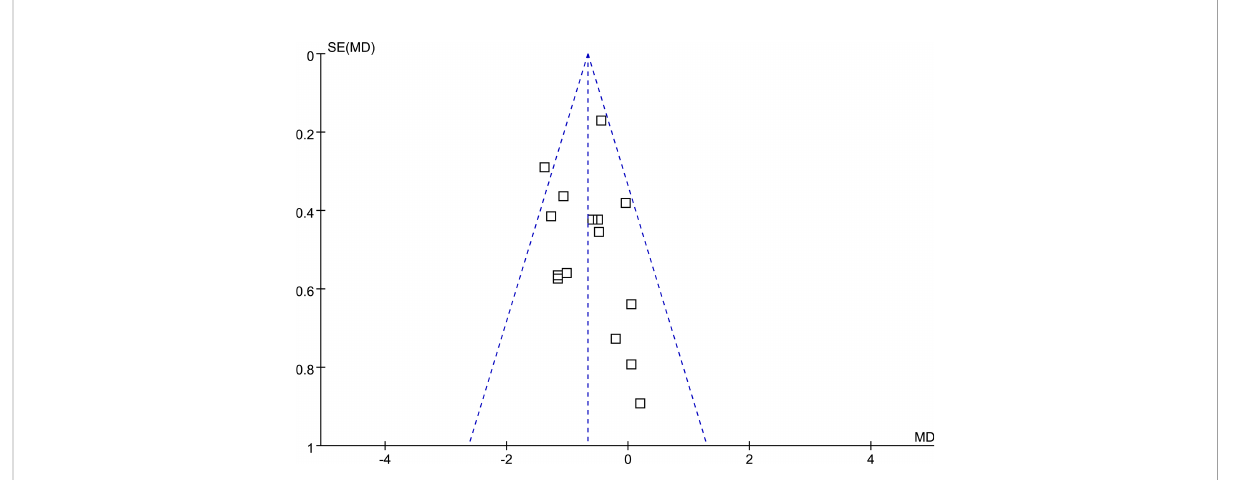
FIGURE 3 Funnel plots for the meta-analysis comparing the in fl uence of DPP4 inhibitors on MAGE with other OADs in T2DM